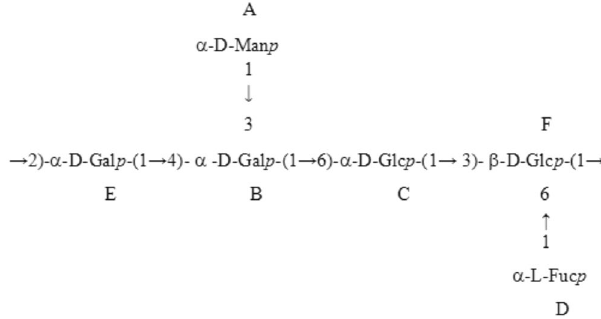
Figure 2. Repeating unit of FVPB2.